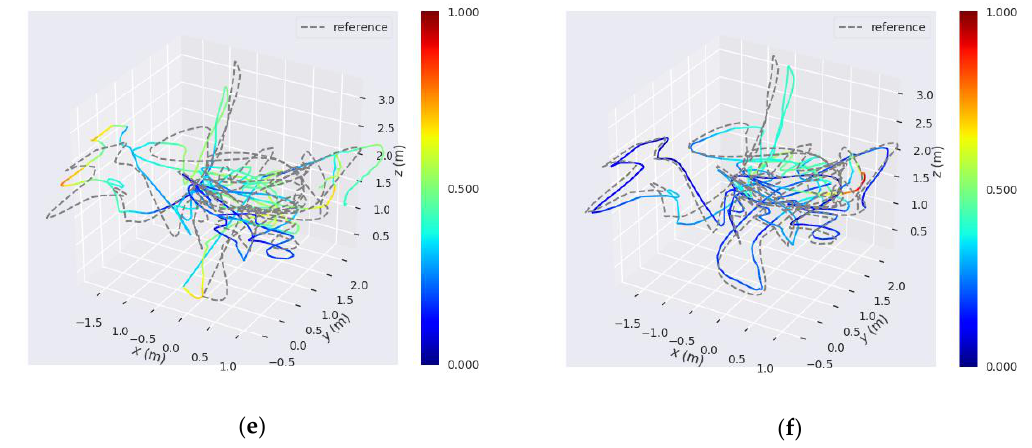
Figure 10. Comparison of several trajectories estimated using reference method and our proposed method. The three accuracy heat maps of the left column are estimated using reference method on the ( a ) MH_03_medium, ( c ) MH_04_difficult, and ( e ) V1_03_difficult sequences. The three accuracy heat maps of the right column are estimated using our proposed method on the ( b ) MH_03_medium, ( d ) MH_04_difficult, and ( f ) V1_03_difficult sequences. The two color bars of each row have the same maximum error and minimum error. The redder the color is, the larger the translation part of ATE is.